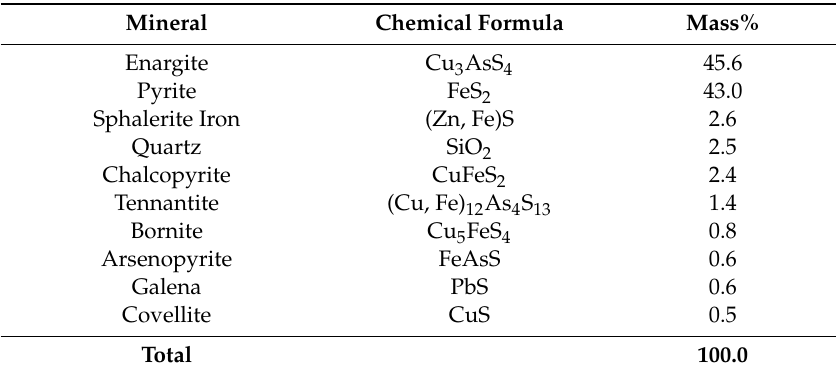
Table 2. XRD results for head